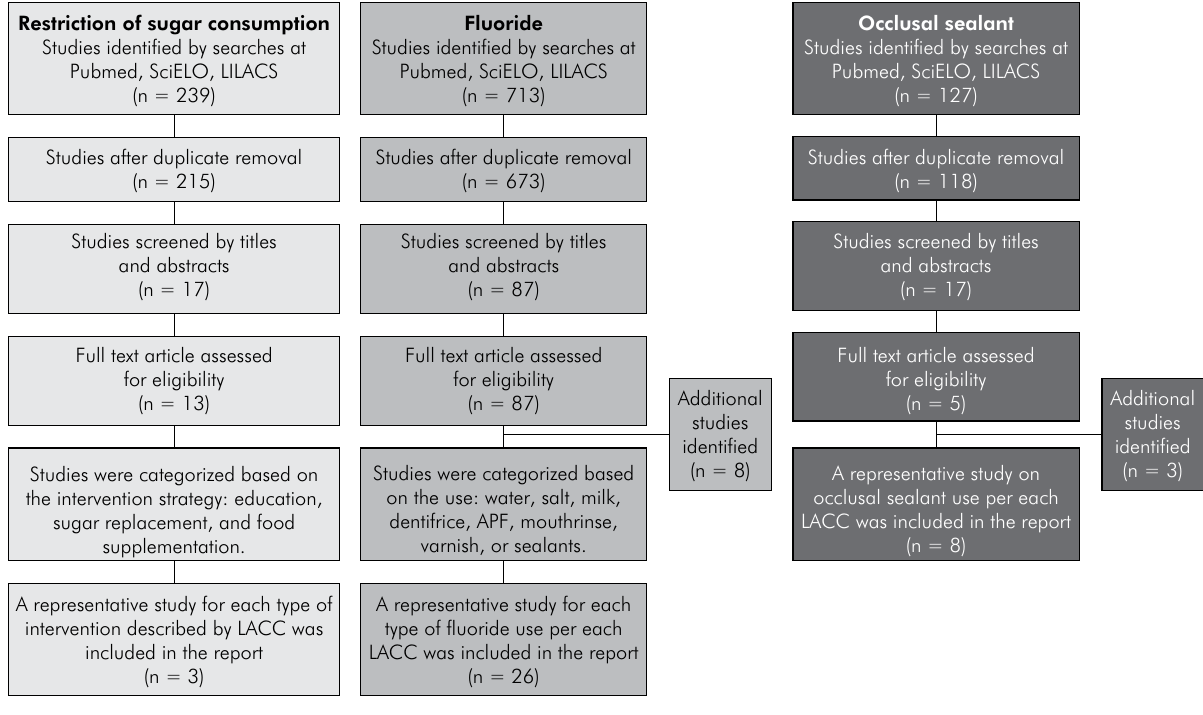
Figure. Summary of systematic search method for identification of interventions based on restriction of sugar consumption, fluoride use, and placement of occlusal sealants for caries control in Latin American and Caribbean countries